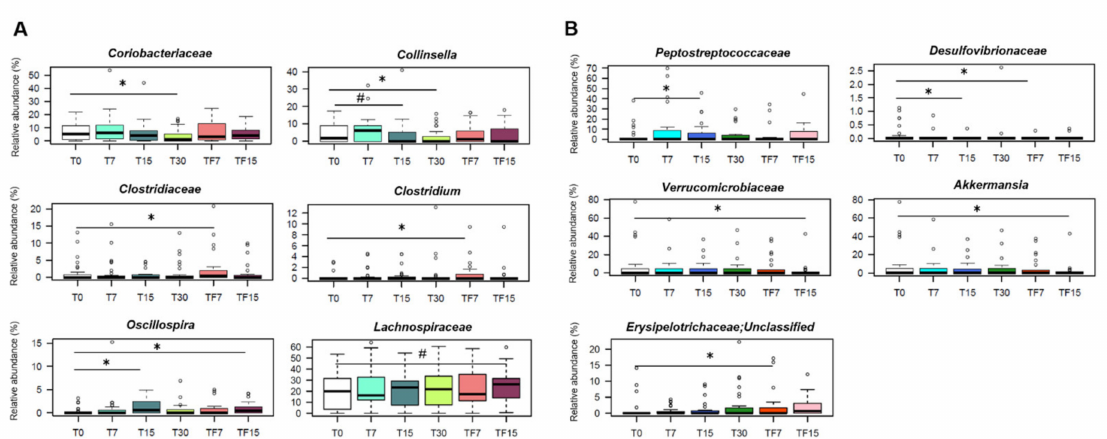
Figure 3. Impact on the gut microbiota of a diet with fresh foods from organic symbiotic agriculture versus probiotic supplementation. Boxplots showing the relative abundance distribution of differentially represented taxa over time, in subjects at risk for metabolic syndrome consuming fresh foods from organic symbiotic agriculture (SA-group) ( A ), or receiving probiotic supplementation (PROB-group) (B). The gut microbiota was profiled at baseline (T0), after 7 (T7), 15 (T15) and 30 (T30) days of intervention, and at follow-up, 7 (TF7) and 15 (TF15) days after the end of the intervention. *, p ≤ 0.05; # , 0.05 < p ≤ 0.1; Wilcoxon